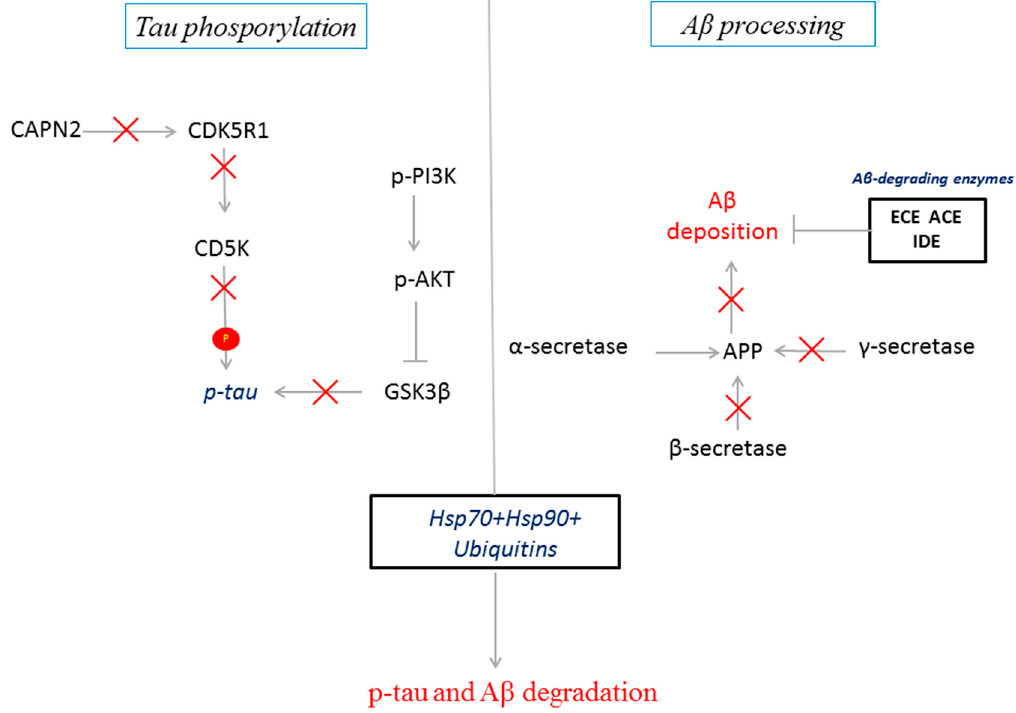
Figure 7. Schematic representation of the modulation of AD-related transcripts by CBD in GMSCs. CBD inhibited the transcription of the main kinases involved in tau phosphorylation (GSK3 β and CDK5) and the enzymes involved in A β processing. In parallel, CBD potentiates the HSP70/HSP90 and the ubiquitin machineries to promote A β and p-tau degradation.